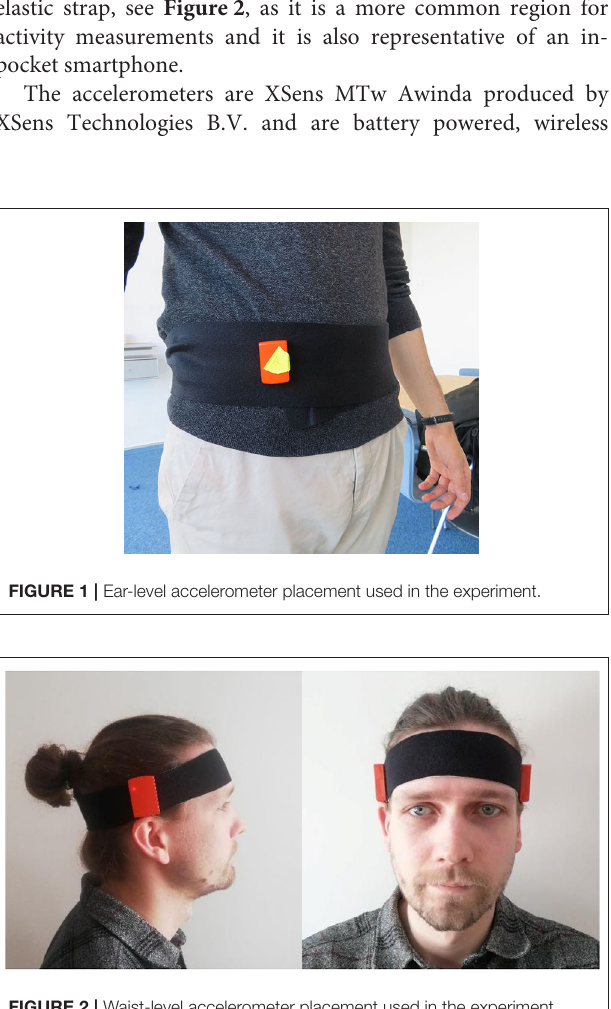
FIGURE 2 | Waist-level accelerometer placement used in the